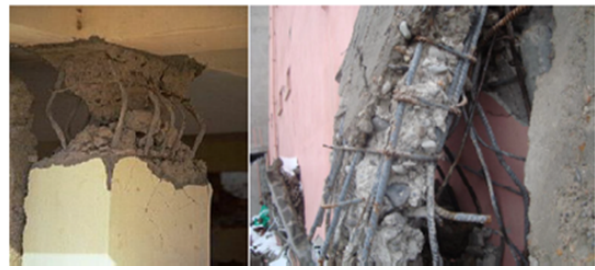
Figure 13. Damage caused by reinforcement detailing mistakes (Source: Erdal Camcı).